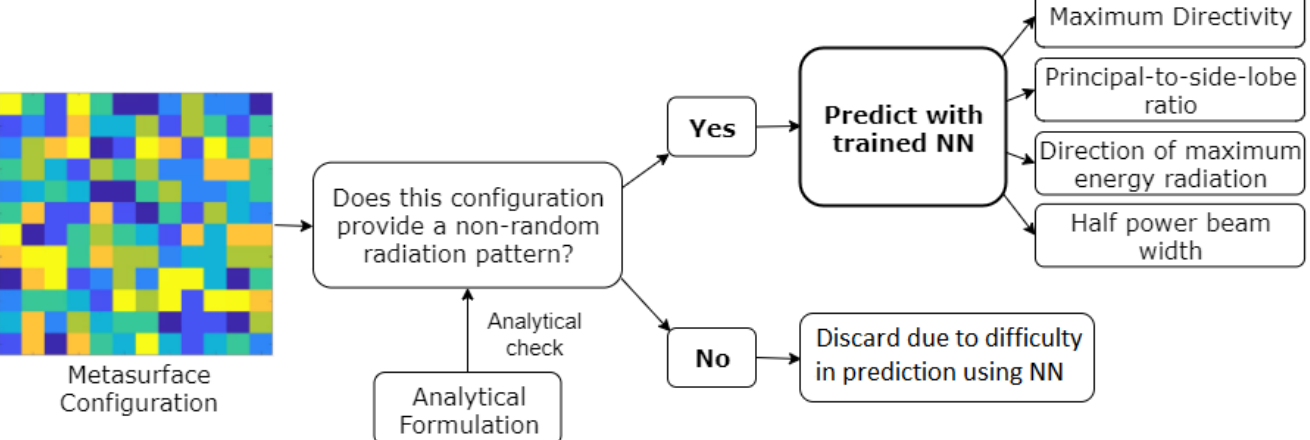
Figure 6. Diagram of the steps performed inside the system once the model is trained for the locally tunable